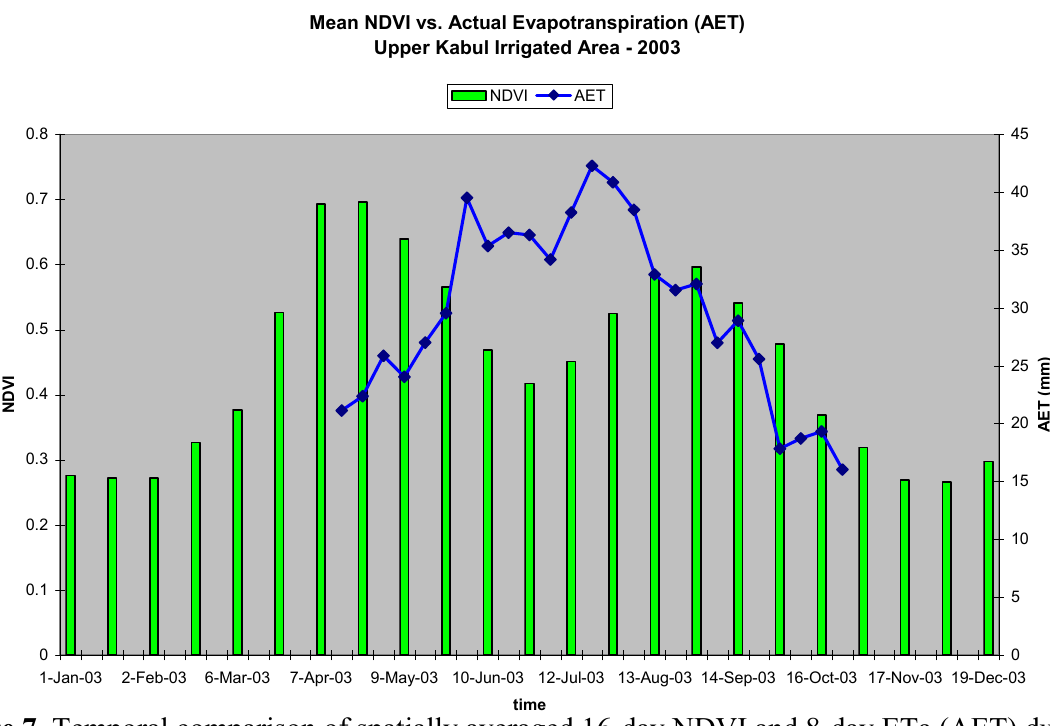
Figure 7. Temporal comparison of spatially averaged 16-day NDVI and 8-day ETa (AET) during the 2003